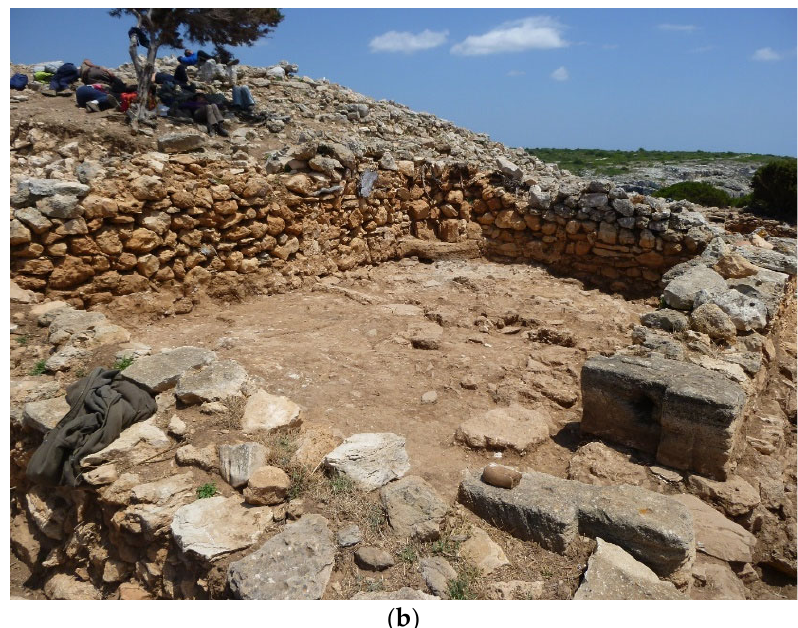
Figure 2. ( a ) The rainwater ancient cistern excavated in the limestone in the Talaiotic time and reused in following historical period (reprinted with permission from [46]. Creative commons (by ‐ nc ‐ nd), 2015. ( b ) Internal view of the house ‐ fort (reprinted with permission from [46]. Creative commons (by ‐ nc ‐ nd), 2015.